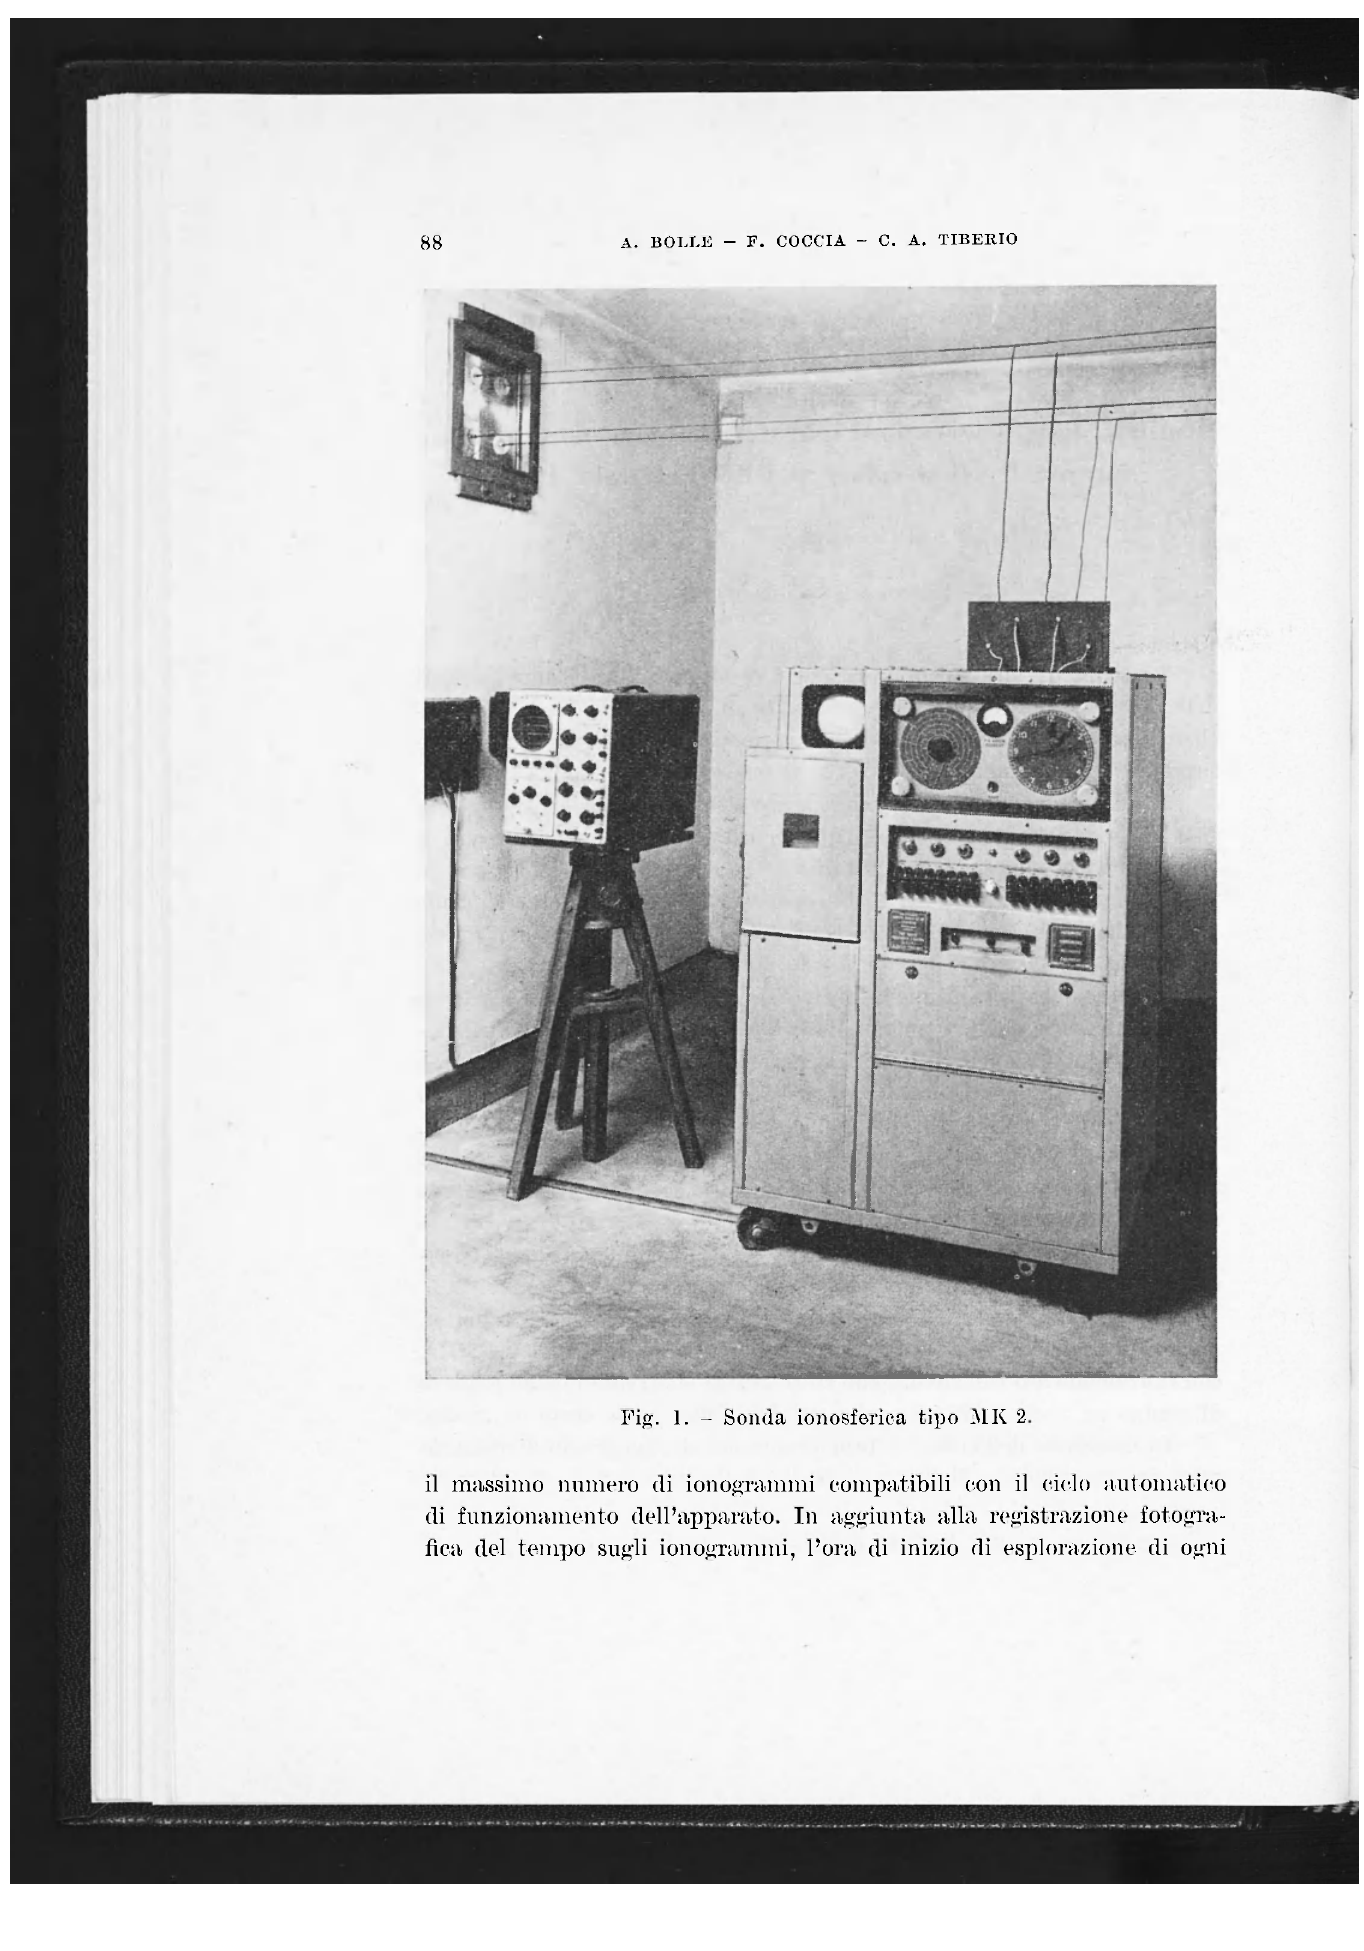
Fig. 1. - Sonda ionosferioa tipo MK